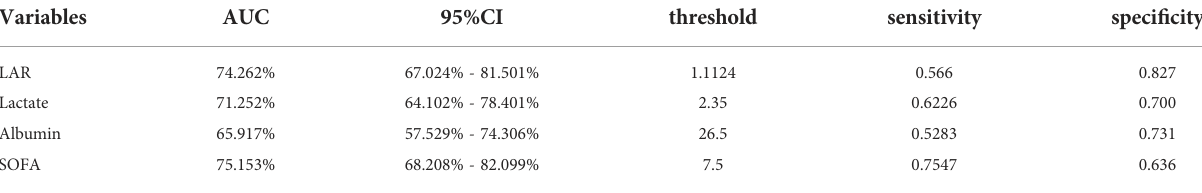
TABLE 4 Information of ROC curves in Figure 2